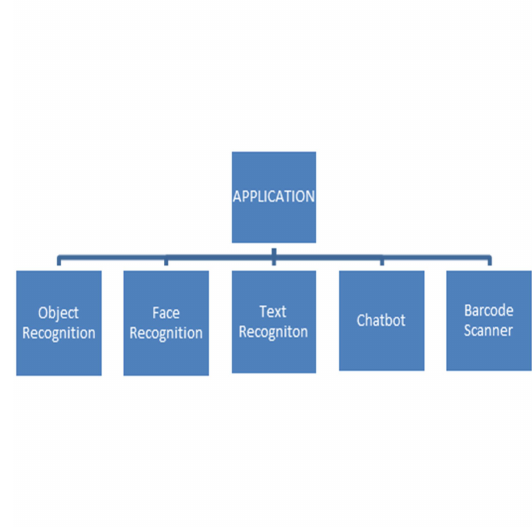
Fig 16 Application working